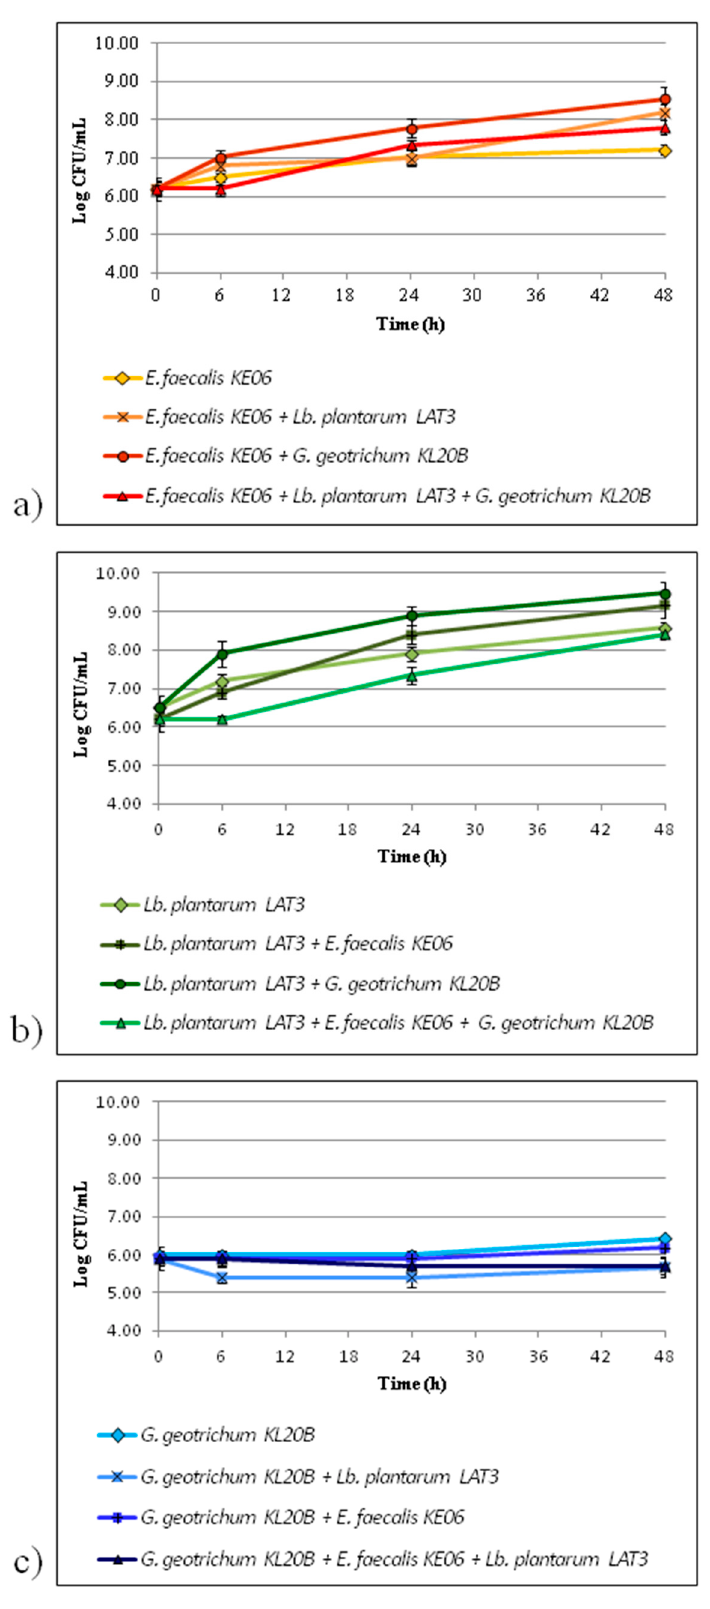
Figure 1. Growth dynamics of ( a ) E. faecalis KE06; ( b ) Lb. plantarum LAT3; ( c ) G. geotrichum KL20B during milk fermentation at 28 °C for 48 h.